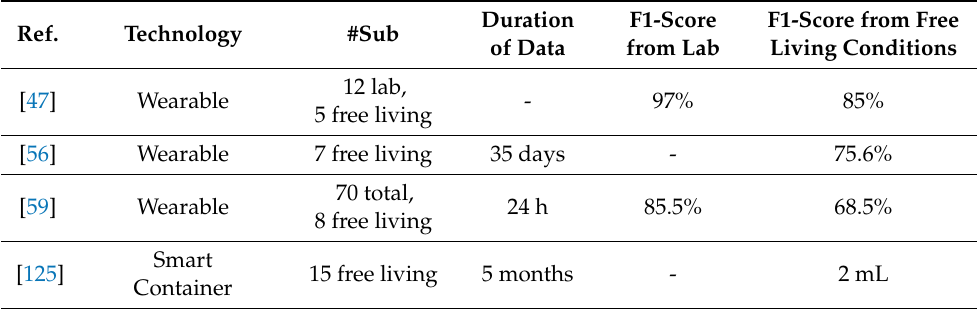
Table 6. Summary of all free-living studies reviewed in this paper. The mL indicates weight error accuracy, not an